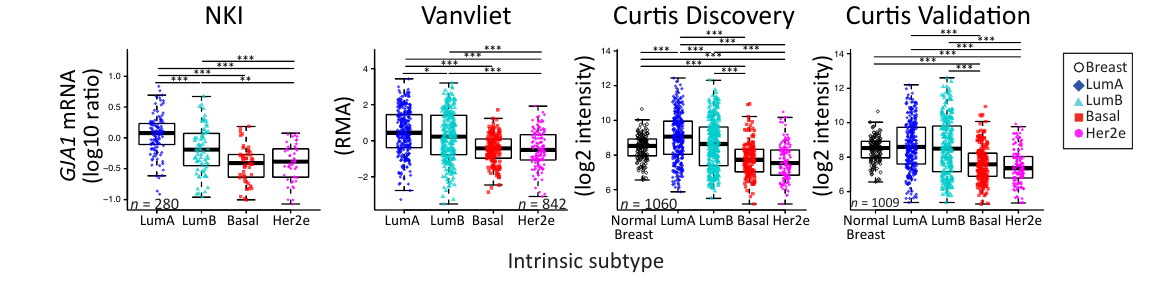
Figure A1. GJA1 mRNA level in breast cancer clinical samples is dependent on breast cancer subtype in four datasets. GJA1 mRNA level in tumors stratified by subtype in Vanvliet, NKI, Curtis Discovery and Curtis Validation datasets. In the legend, “Breast” indicates adjacent normal breast tissue. p value: * <0.05; ** <0.01; *** <0.001.